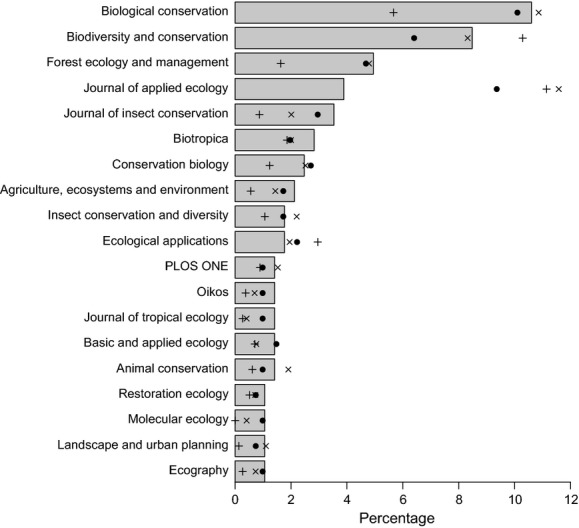
Data contributions by journal. The percentage of Data Sources (bars), Studies (circles), Sites (crosses) and samples (pluses) taken from each journal. Only journals from which more than one Data Source was taken are shown.